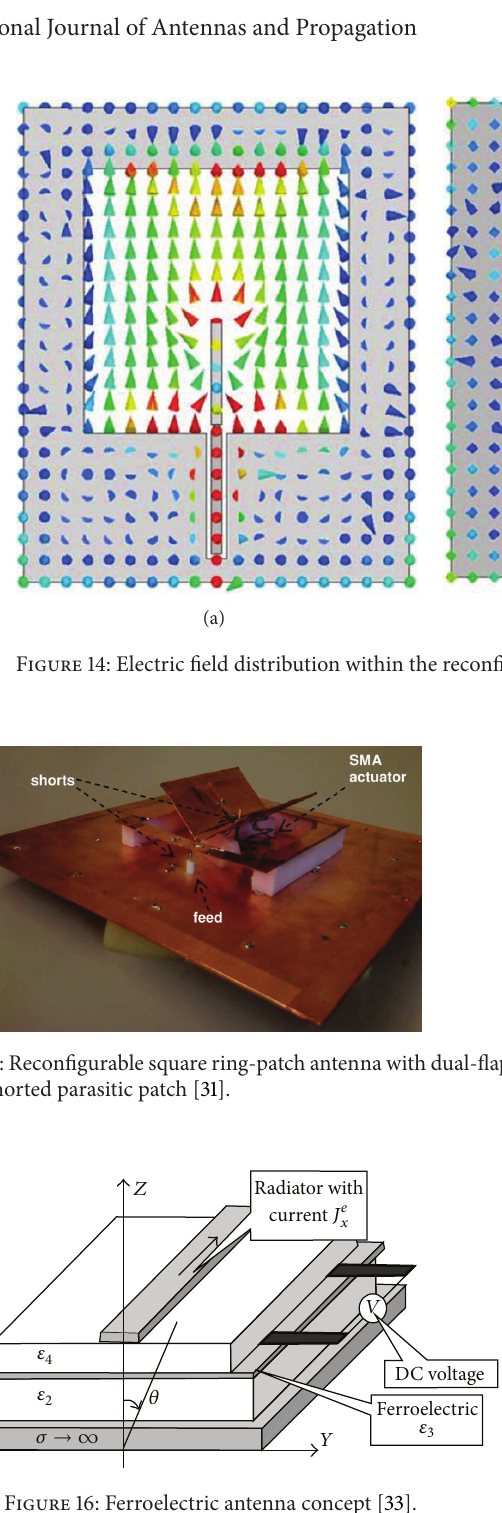
Figure 16: Ferroelectric antenna concept [33].